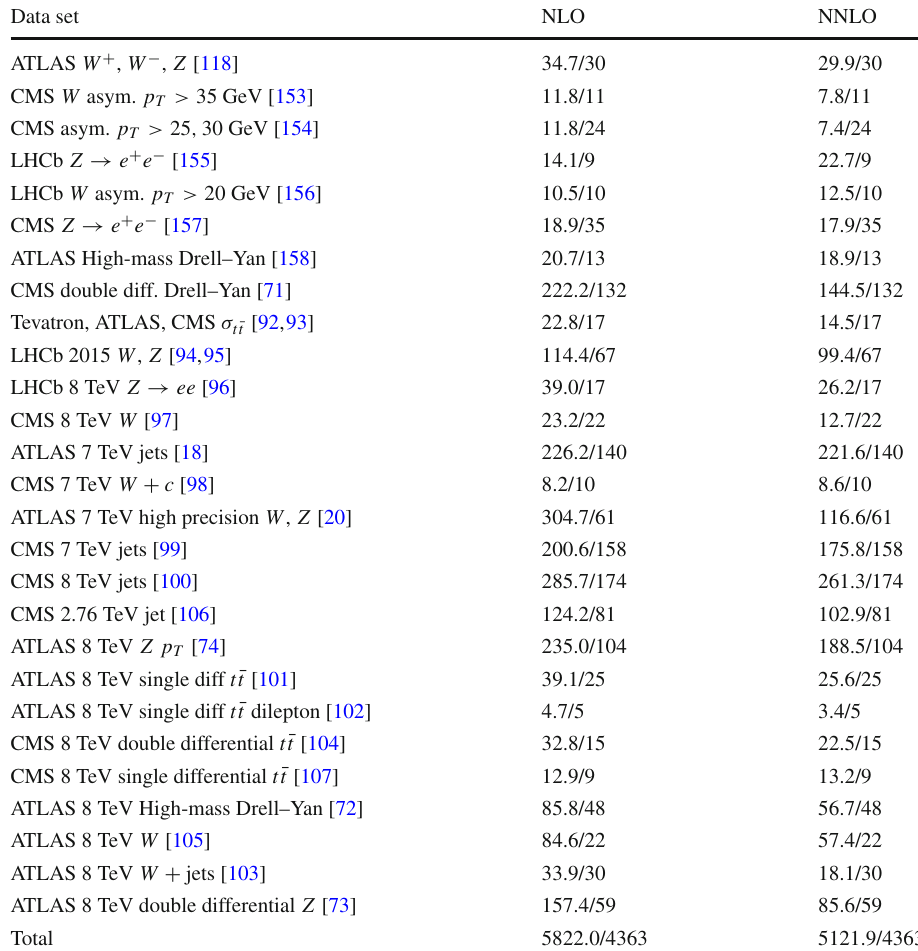
Table 7 The values of χ 2 / N pts. for the LHC data sets included in the global fit and the overall global fit χ 2 / N at NLO and NNLO. The corresponding values for the non-LHC data sets are shown in Table 6, and the total value corresponds to the sum over both